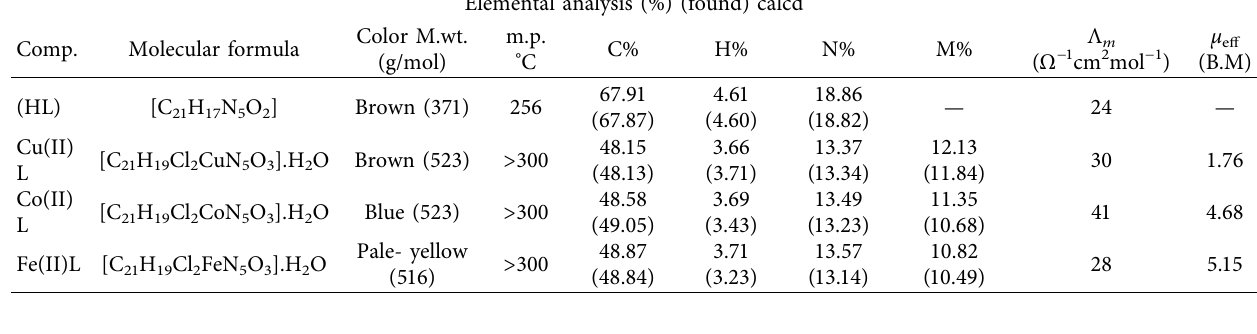
Table 1: Physical properties and elemental analytical data of the azo dye ligand and its metal complexes. Elemental analysis (%) (found) calcd Comp. Molecular formula